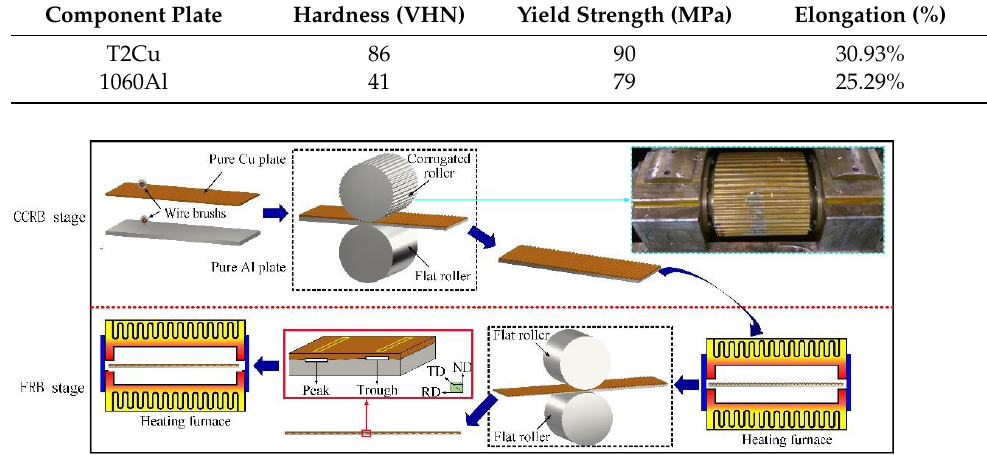
Table 1. Chemical composition of T2 Cu and 1060 Al (wt.%).